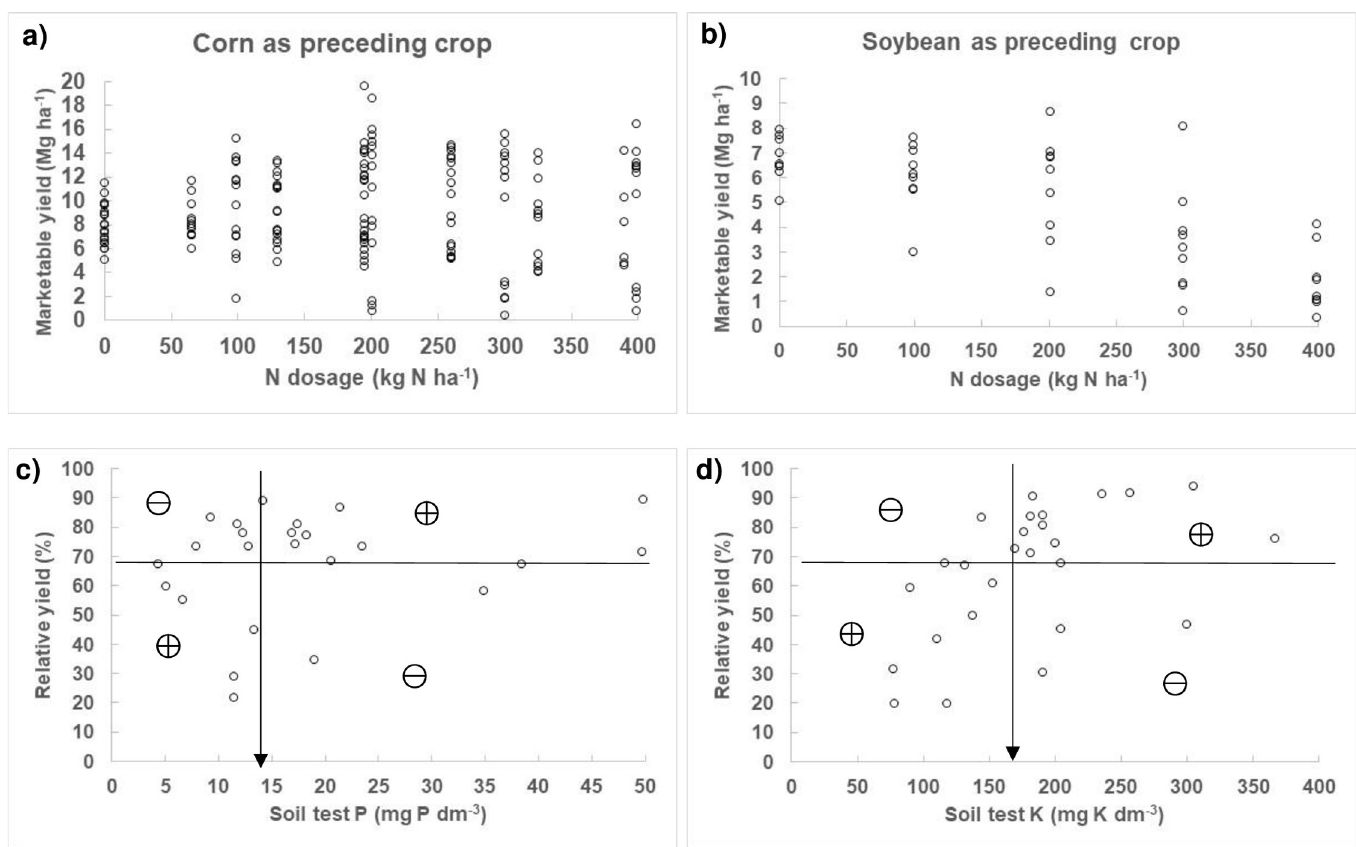
Fig 1. Response of garlic marketable yield, N dosage and soil tests for P and K recorded in experimental sites (2015–2017). The N model showed the apparent impact of preceding crops on yield and response to N fertilization (a, b). The P model indicated critical soil test P value, at classification accuracy of 0.708 (c). Classification accuracy of the K model was 0.815 (number of points in the � quandrants divided by total number of points) about soil test K close to 160 mg Mehlich-1 K dm -3 (d).